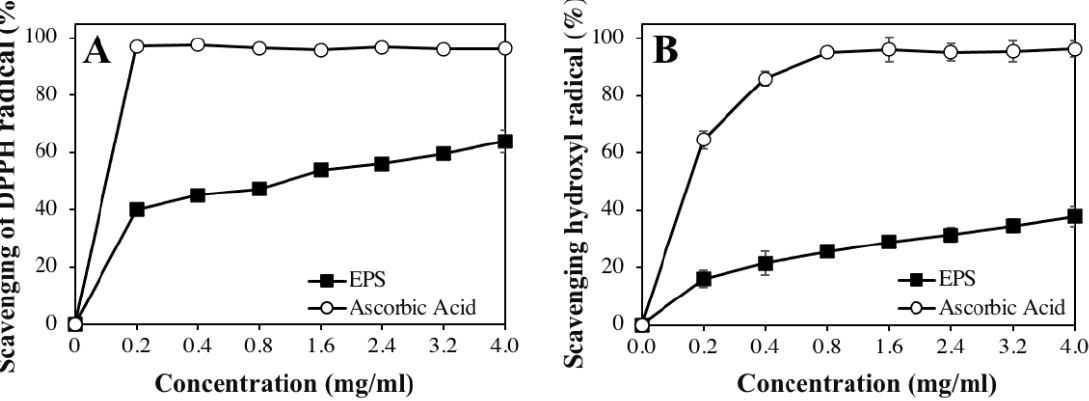
Figure 6. Antioxidant activities of EPS produced by B. velezensis VTX20. Scavenging activity on DPPH free radicals ( A ) and hydroxyl radicals ( B ).